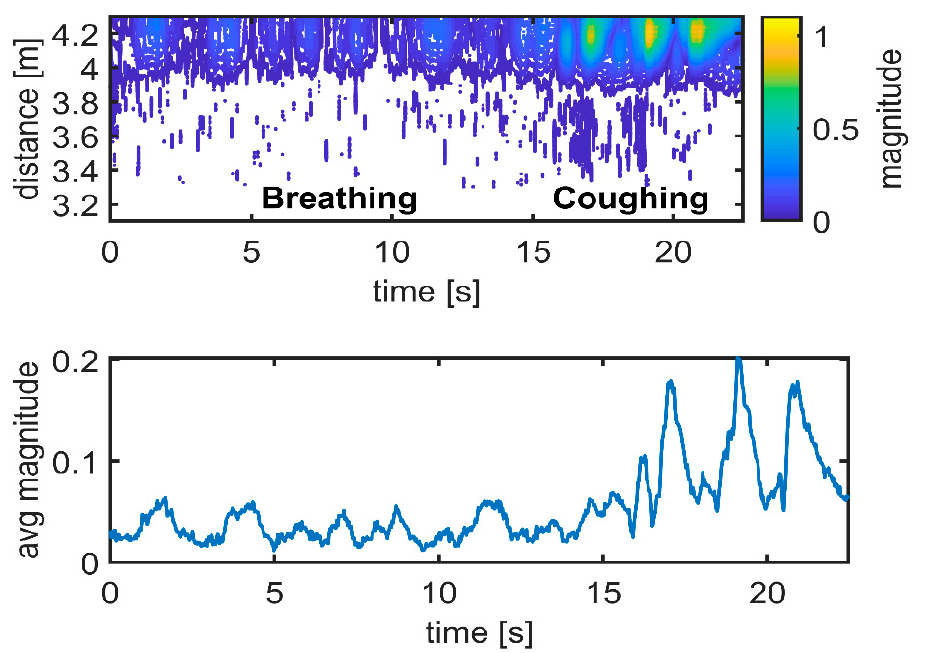
Figure 11. Respiration and coughing. Experimental results: sitting frontside. Magnitude unit [ µ V] is normalized.